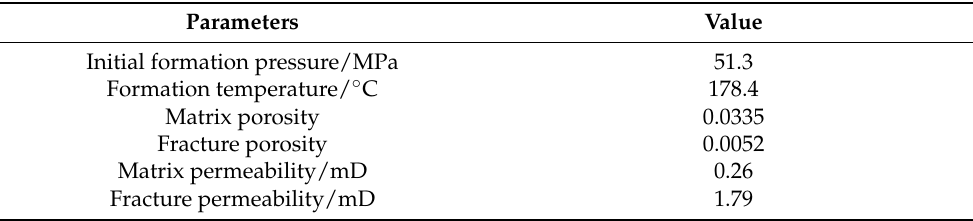
Table 1. Formation statics